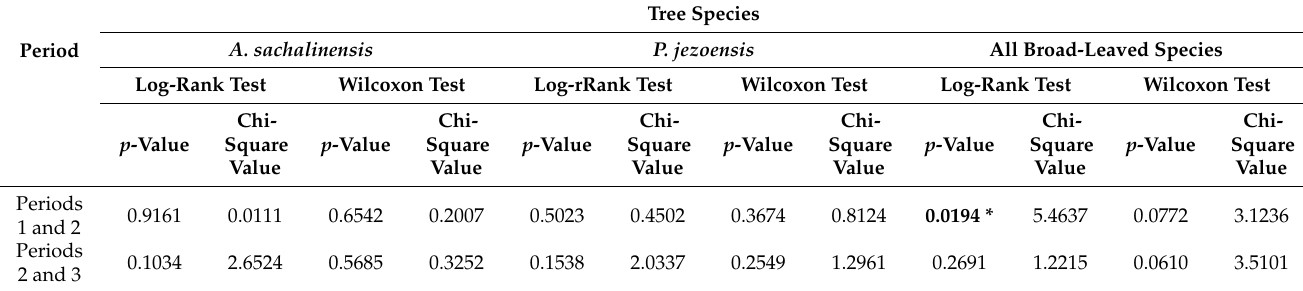
Table 2. Log-rank test and Wilcoxon results of each tree group to compare the three observ- ational periods.